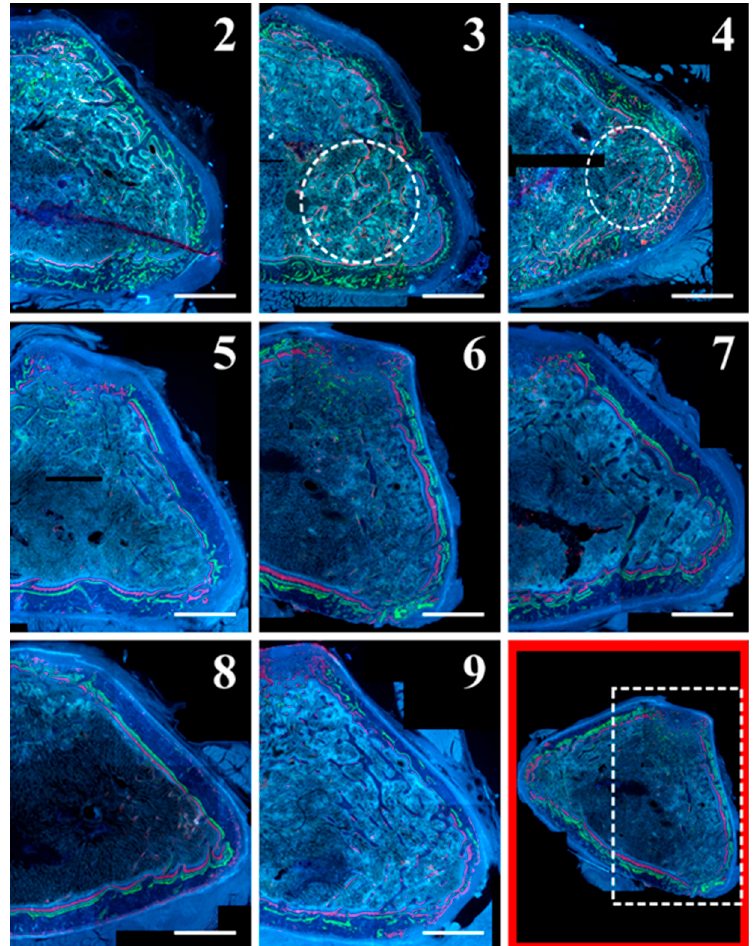
Figure 10. Details of micrographs from femoral distal metaphysis transversal sections of all animal groups under fluorescence microscope. In the bottom right image outlined in red (as an example), the white dashed rectangle indicates the femur metaphysis portion showed in all micrographs (2–9). Note the abundant red fluorescence mostly on the surface of the few trabecular remnants of groups 3 and 4 (encircled areas). Scale bar: 1 mm.